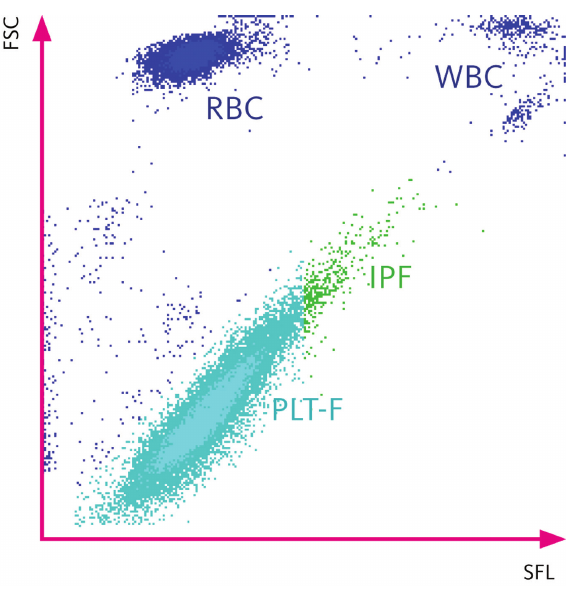
Figure 1: Scatterplot of reticulated thrombocyte measurement by Sysmex XN automated hematology